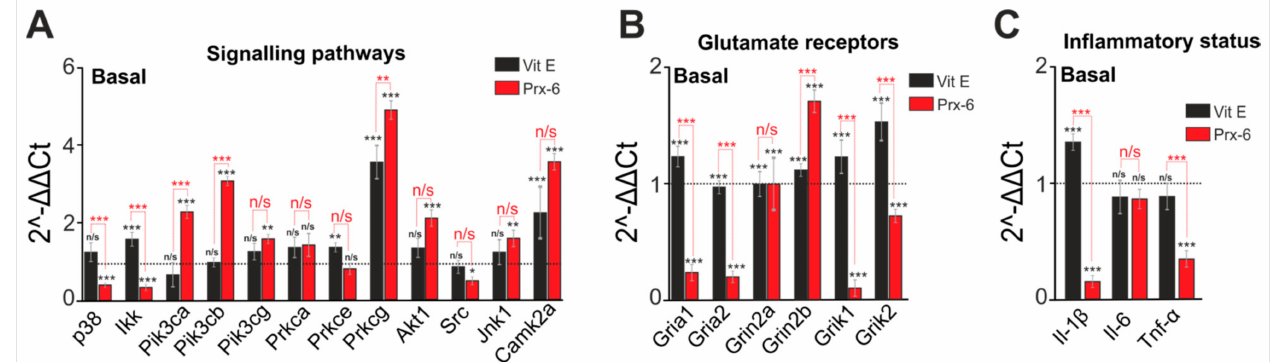
Figure 6. Effect of Prx-6 and Vit E on the basal level expression of genes encoding signal kinases ( A ), subunits of excitatory glutamate receptors ( B ) and proinflammatory factors ( C ). Dashed line level of gene expression in controls (without tested compounds). Statistical significance was assessed using paired t -test. n/s—data not significant ( p > 0.05), * p < 0.05, ** p < 0.01, and *** p <